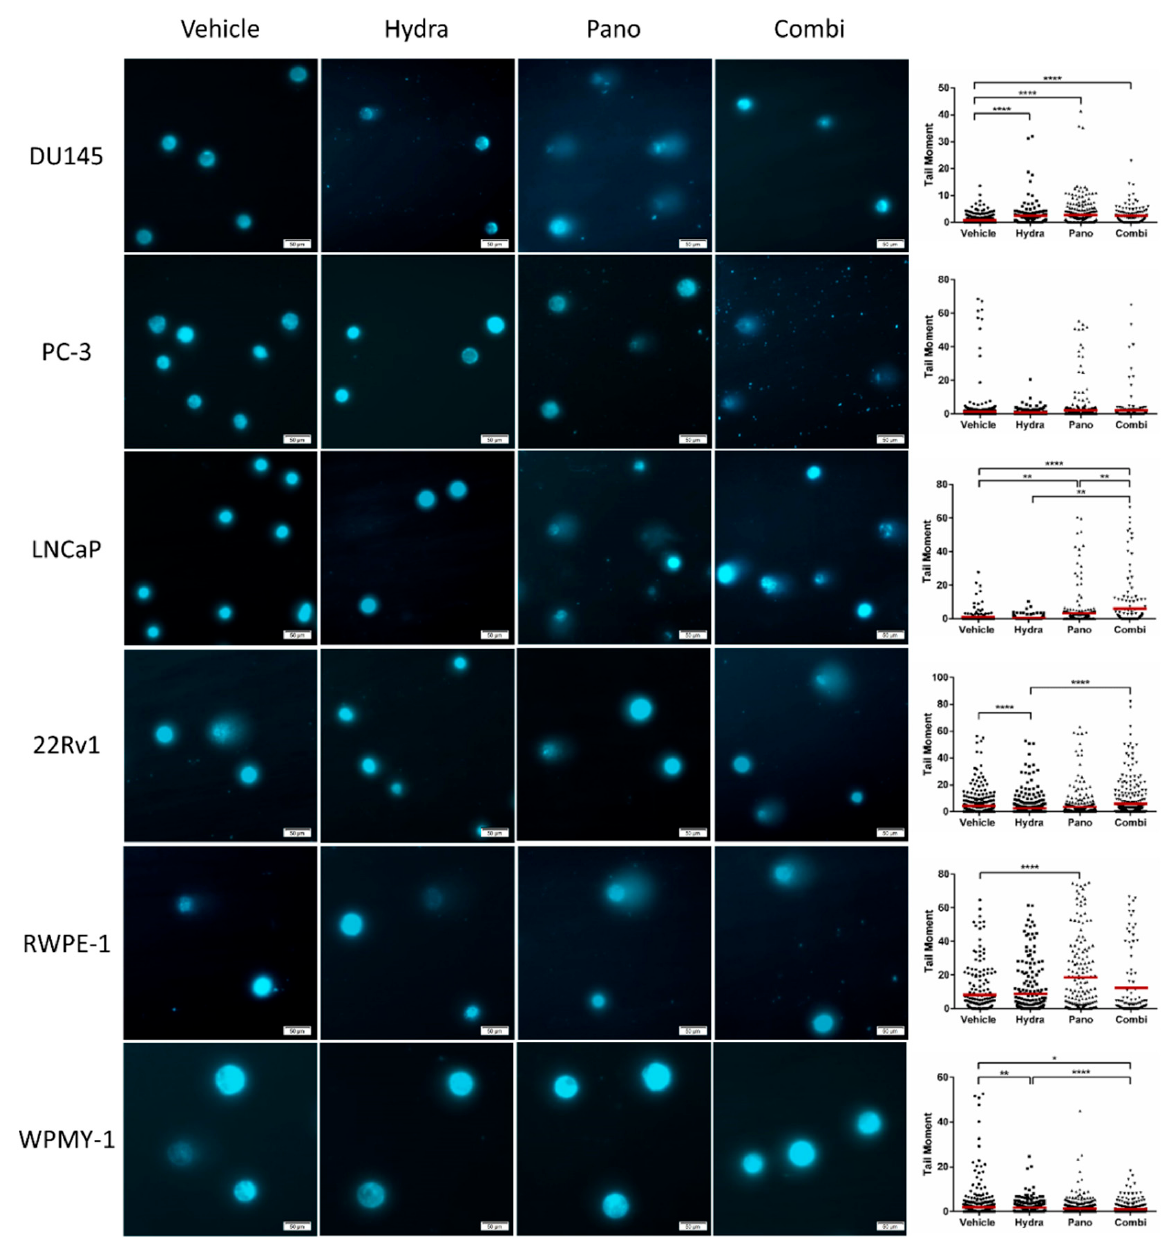
Figure 4. Effect of combined hydralazine and panobinostat treatment in DNA damage of PCa cell lines by comet assay. DNA damage evaluation was determined by measuring tail moment (tail % DNA × means of head × tail distance) of at least 50 comets per condition. Representative pictures were taken with Olympus IX51 microscope at 200 × magnification (scale bar 50 µ m) ( left panel ). Results are represented by the mean of three biological replicates ( n = 3) analyzed by Kruskal–Wallis with Dunn’s test for multiple comparisons ( right panel ). Drug concentrations: DU145–Hydra: 50 µ M, Pano: 5 nM; PC-3, RWPE-1 and WPMY-1–Hydra: 100 µ M, Pano: 10 nM; LNCaP–Hydra: 100 µ M, Pano: 5 nM; 22Rv1–Hydra: 75 µ M, Pano: 1 nM). * p < 0.05; ** p < 0.01; **** p <